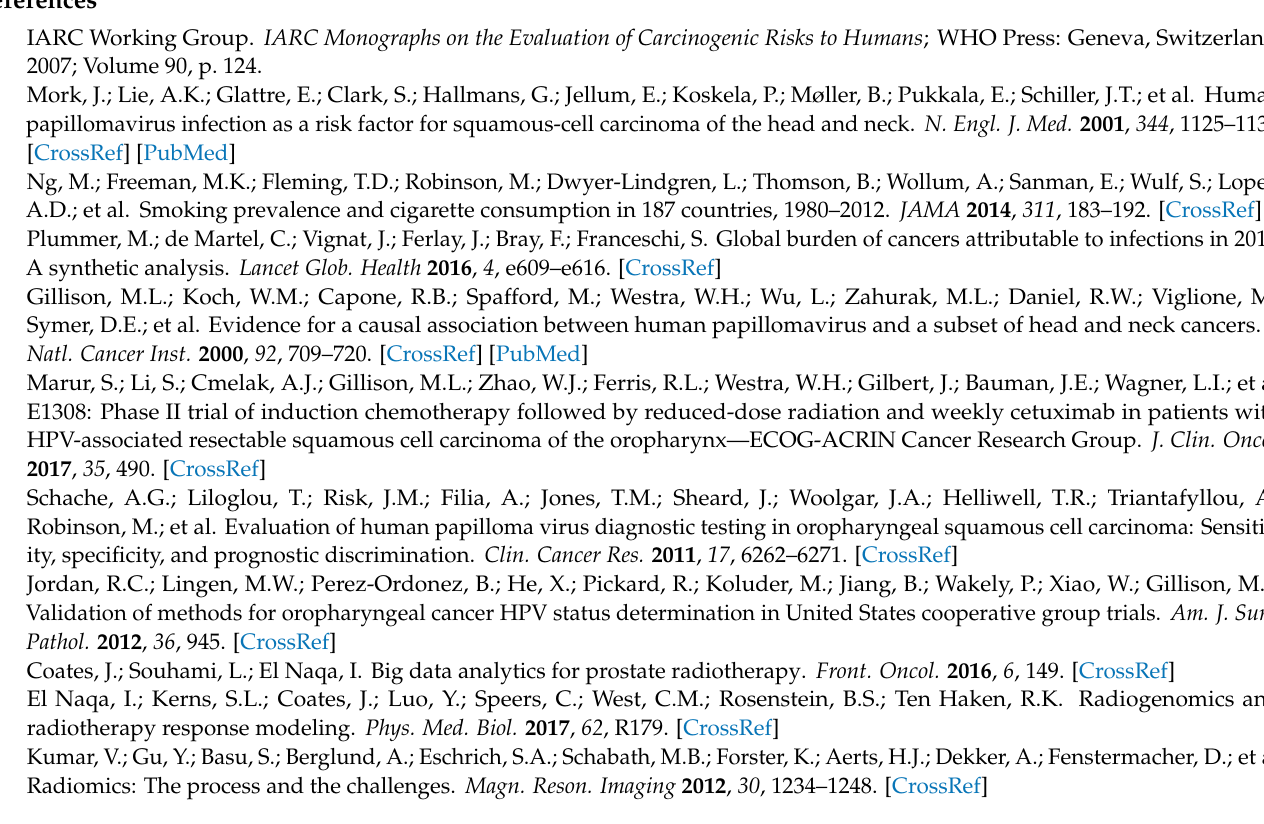
Figure A2. Example CT slices with: ( a ) HPV-positive example (OPC dataset), ( b ) HPV-negative example (OPC dataset), ( c ) HPV-positive example (HNSCC dataset) and ( d ) HPV-negative example (HNSCC dataset). Examples ( e , f ) are showing different slices of the same CT image, while ( e ) features normal quality ( f ), which suffers from artifacts. The red delineation marks the gross tumor volume. The HU window was set to range from − 250 to